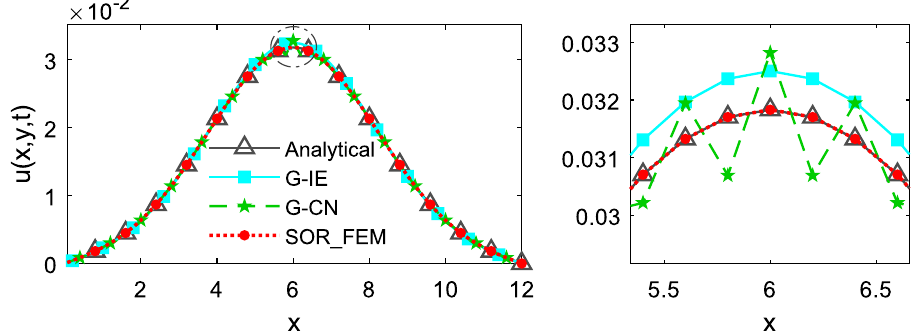
Figure 4. Temperature along the x-axis at time t = 0.5.